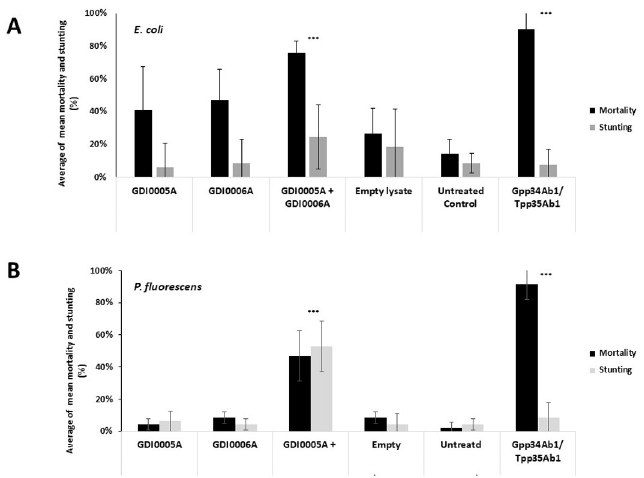
Fig 2. Activity of GDI0005A and GDI0006A proteins against western corn rootworm (WCR). In Escherichia coli (A) and Pseudomonas fluorescens (B) strain lysates tested on WCR neonates (USDA ARS non-diapause susceptible colony) 5 days after treatment and infestation using artificial diet overlay bioassays. Activity was evaluated by assessing the percentage of mortality (black boxes) and the percentage of stunting (grey boxes). Each larva was fed on ~200 μ L of WCR artificial diet overlaid with 20 μ L of bacterial lysate. Bacterial lysates contained GDI0005A, GDI0006A or both proteins mixed. Negative controls consisted of lysates from bacteria transfected with the empty expression plasmid (empty lysate) and sterilized water (untreated control). The positive control consisted of lysates from bacteria transfected with a plasmid expressing the commercial Gpp34Ab1/Tpp35Ab1 binary proteins. Each experiment consisted of at least six 96-well plates each with 8 wells per treatment, totaling a sample size of 48 per treatment per experiment. A Fisher exact test was used to compare treatment results to the empty lysate at significance levels of P < 0.05 � and < 0.005 �� . The untreated control was only used to evaluate the quality and reliability of each bioassay. The error bars show the standard error of the mean (SEM).